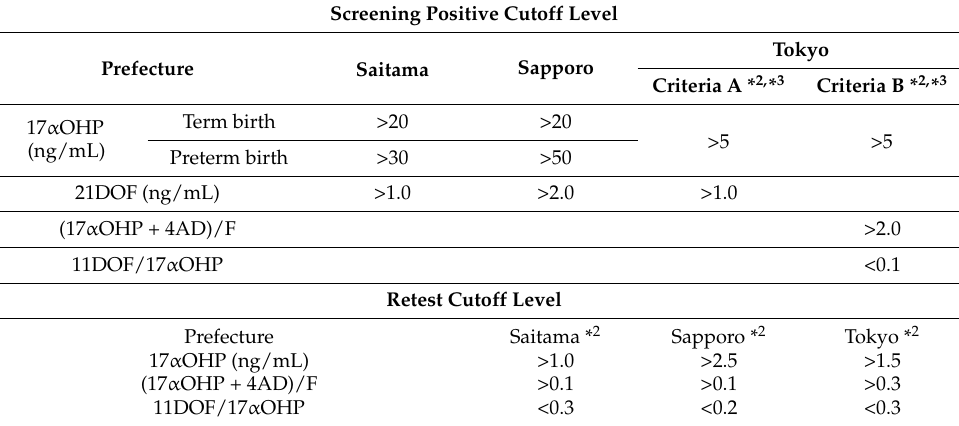
Table 4. Cutoff level of 17 α OHP and other steroids assayed by LC-MS/MS in Saitama, Sapporo and Tokyo, Japan * 1 . Screening Positive Cutoff Level Prefecture Saitama